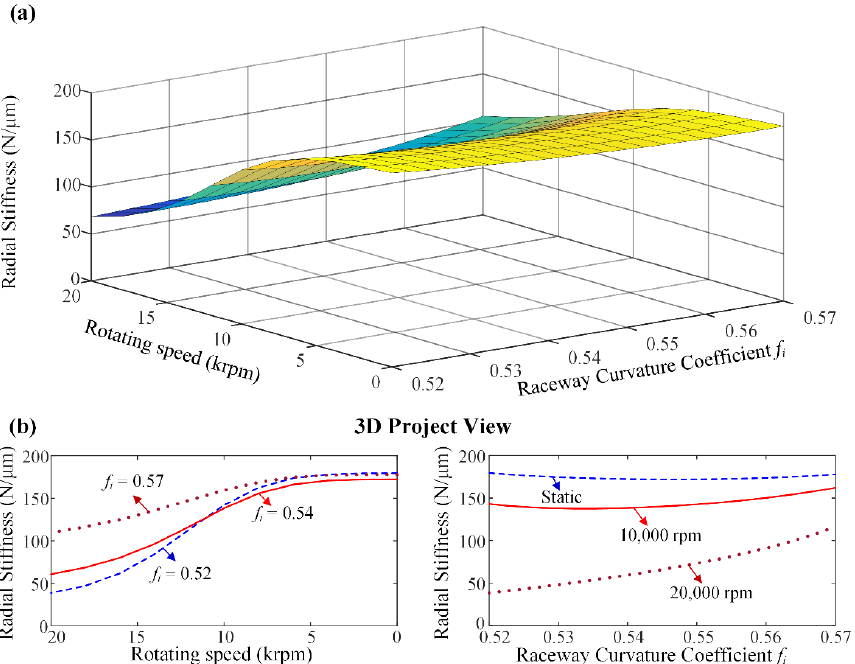
Figure 17. The influences of raceway curvature coefficient and rotating speed on bearing stiffness with constant initial contact angle and radial clearance: ( a ) the three-dimension curved of the rotating speed, inner raceway curvature coefficient, and radial stiffness; ( b ) the two-dimensional projection curves of three-dimensional surface ( a ).